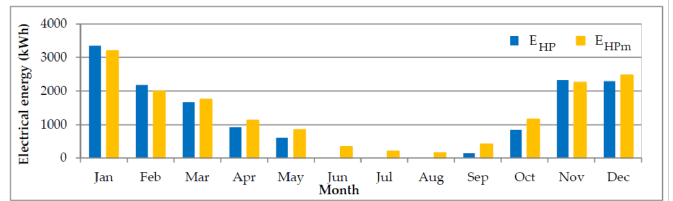
Figure 17. The monthly electrical energy consumption of the geothermal system obtained through Trnsys17 numerical simulations (E HP ) and measured by the monitoring system (E HPm ).